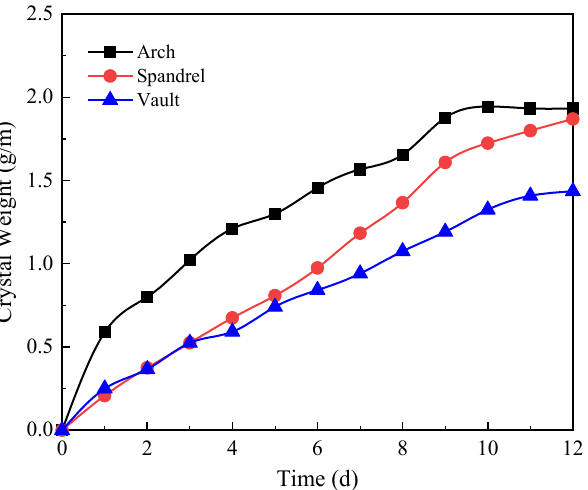
Figure 8. Crystal weight change curves at different parts of circular drainage